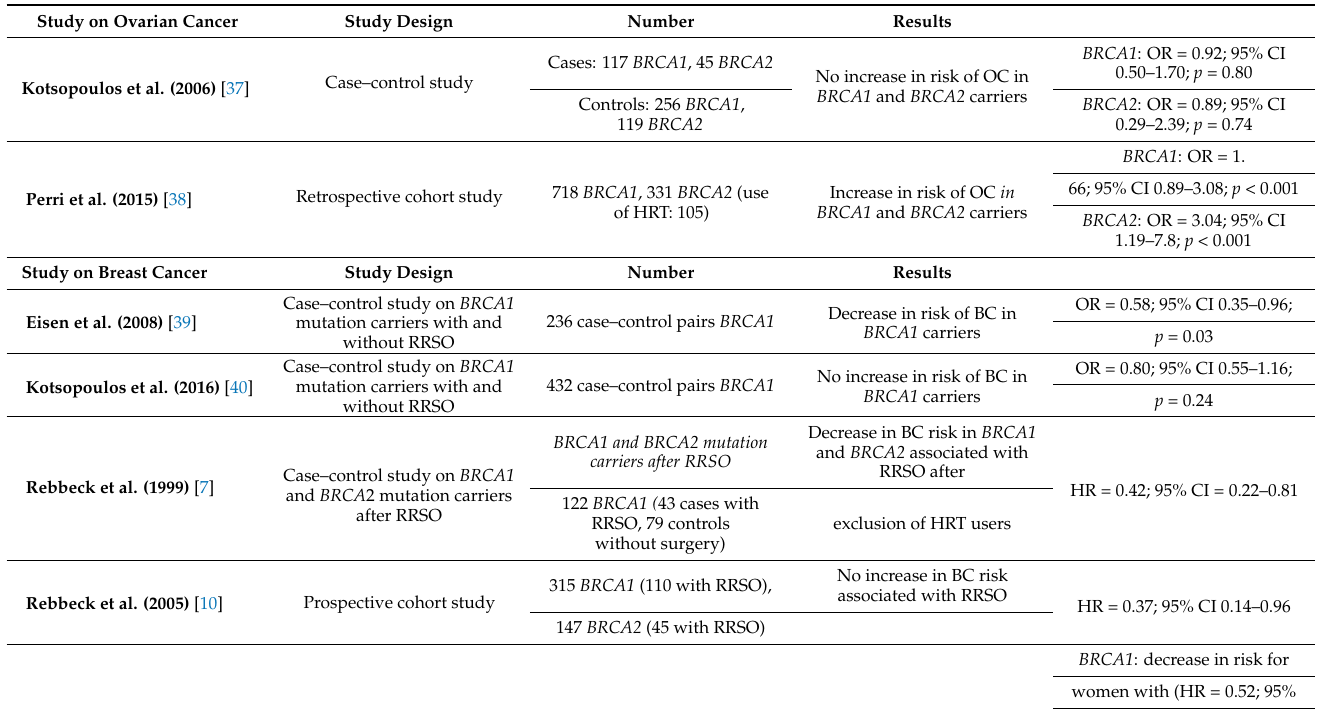
Table 1. Most relevant study on HRT in BRCA mutation carriers and risk of ovarian, endometrial, and breast cancer. Revised and modified from Huber et al. (2020)